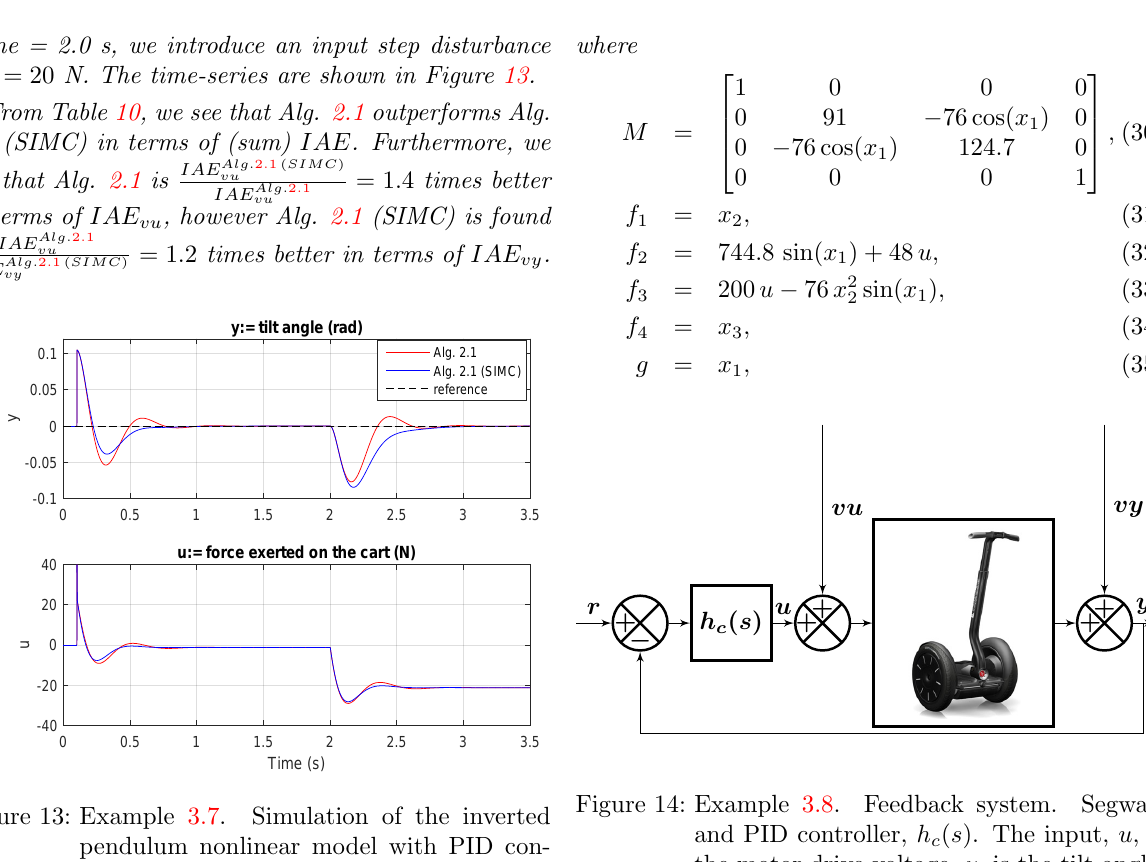
Figure 13: Example 3.7. Simulation of the inverted pendulum nonlinear model with PID con- trol. Output and input step disturbance at, Time = 0.1 s and, Time = 2.0 s, i.o. Input u is limited.